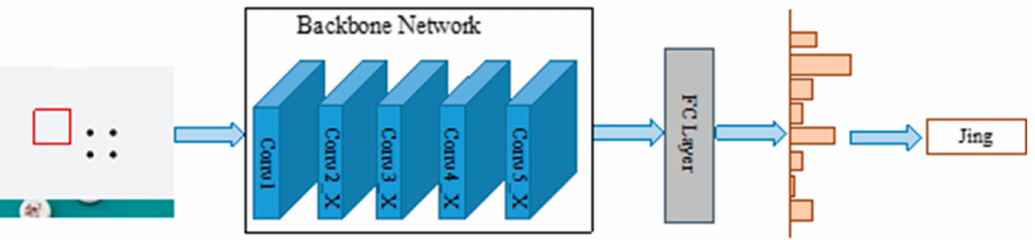
Figure 5. ResNet-based Chinese character recognition network.